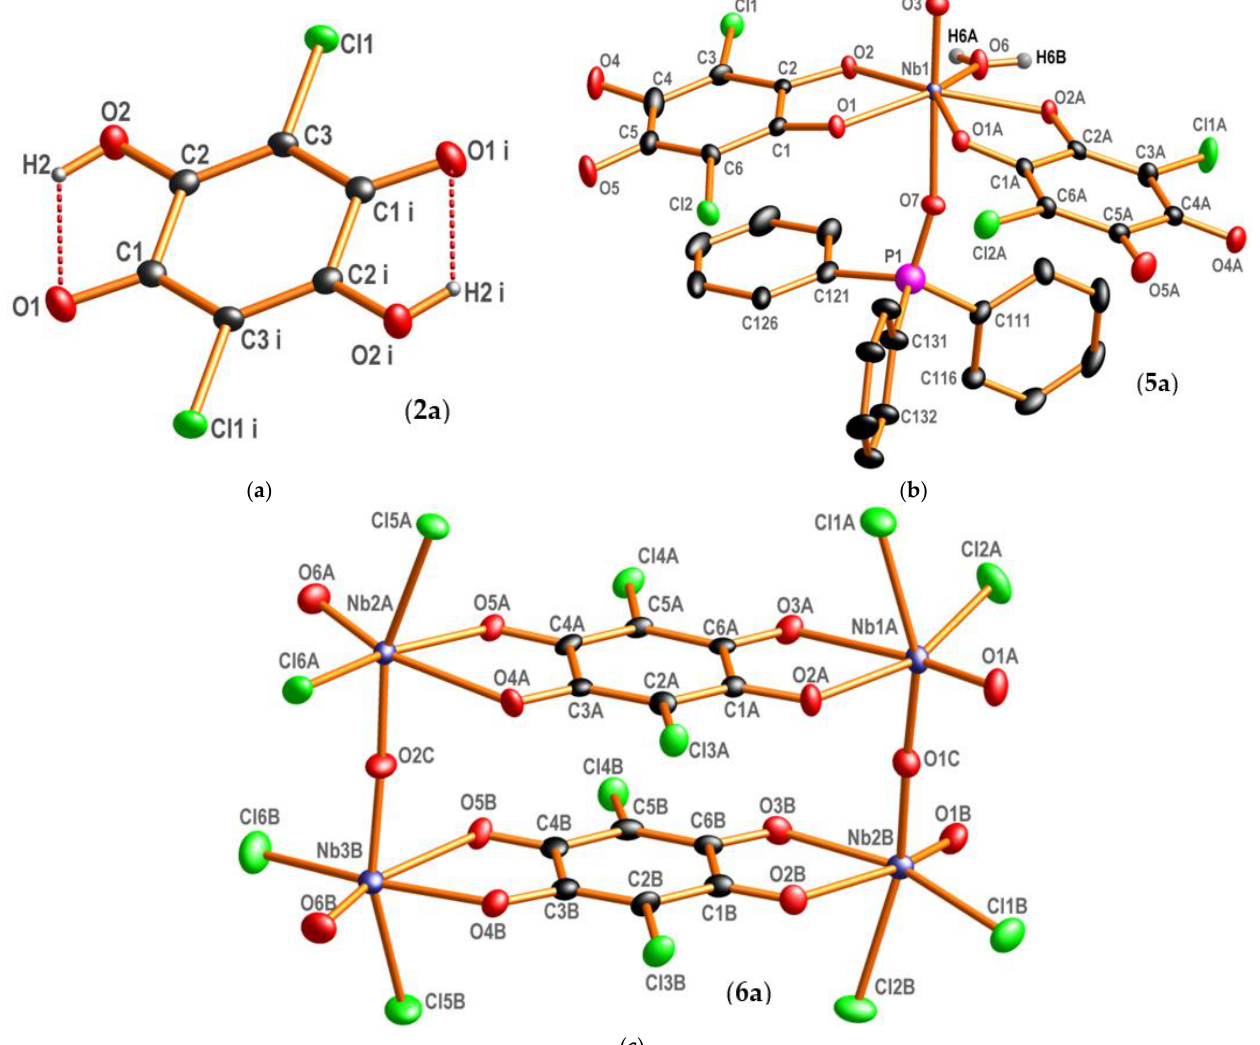
Figure 1. Perspective view of ( a ) (caH 2 ) ( 2a ); atoms generated by symmetry are indicated by lower case roman numerals corresponding to the symmetry operator (i) 1 − x, − y, − z; ( b ) cis - [NbO(ca) 2 (H 2 O)OPPh 3 ] − ( 5a ); and ( c ) [Nb 4 O 4 (ca) 2 ( μ 2 -O) 2 Cl 8 ] 4 − ( 6a ). Ellipsoids are drawn at a 50% probability. Hydrogen atoms, counter ions, and solvate molecules are omitted for clarity. Carbon atoms in counter ions in 5 and 6 , as well as the phenyl rings of the OPPh 3 in 5 , show typical small dynamic disorders which do not significantly influence the coordination geometries observed, and they were not solved. Table 1. Crystallographic data for (caH 2 )·2H 2 O ( 2 ), (Et 4 N) cis -[NbO(ca) 2 (H 2 O)OPPh 3 ]·3H 2 O·THF ( 5 ) and (Et 4 N) 4 [Nb 4 O 4 (ca) 2 ( μ 2 -O) 2 Cl 8 ]·2CH 3 CN ( 6 ).